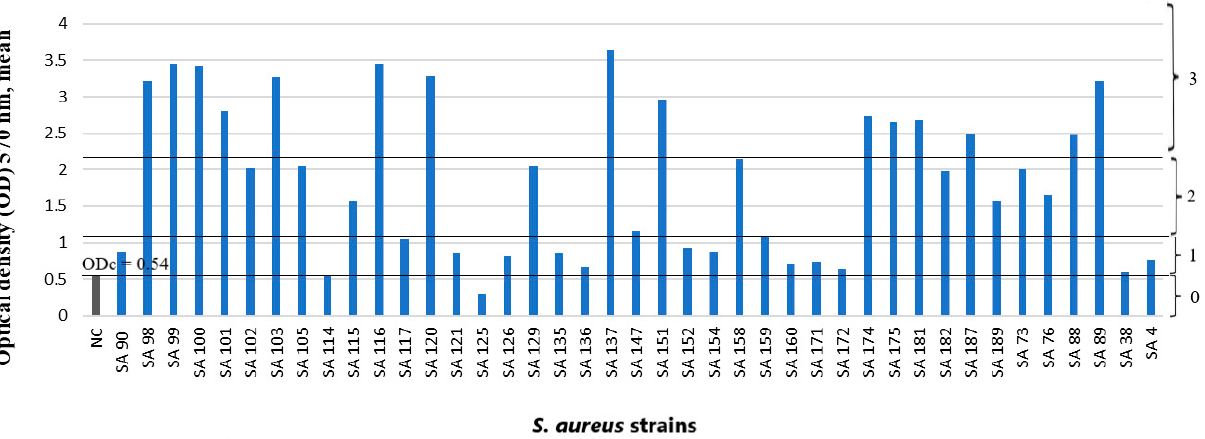
Figure 1. Biofilm production capability on microtiter plate of 41 S. aureus strains. Bars represent mean values of OD (measured at wavelength of 570 nm). Trypticase soy broth with 1% glucose as a negative control (NC). The number designates the participant; the letters indicate the strain isolated: SA— Staphylococcus aureus . The cut-off value (ODc) and biofilm production capacity levels are marked with horizontal lines: 0—biofilm nonproducers; 1—weak biofilm producers; 2—moderate biofilm producers; 3—strong biofilm producers.